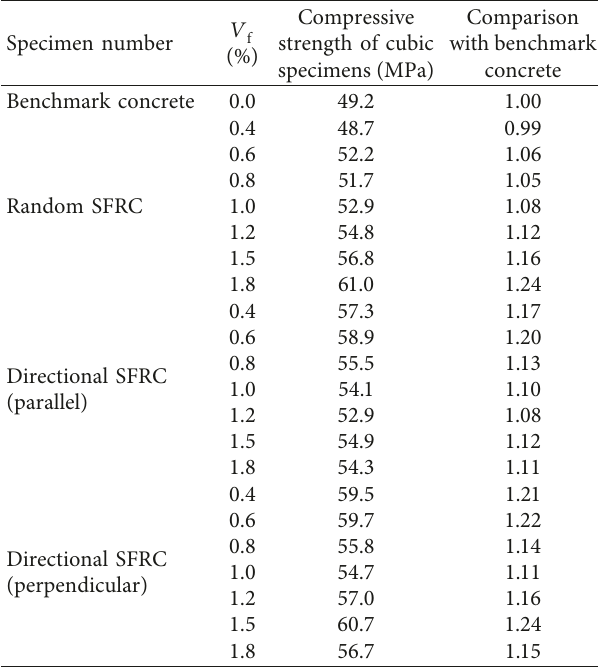
Table 3: Compressive strength of cubic specimens.